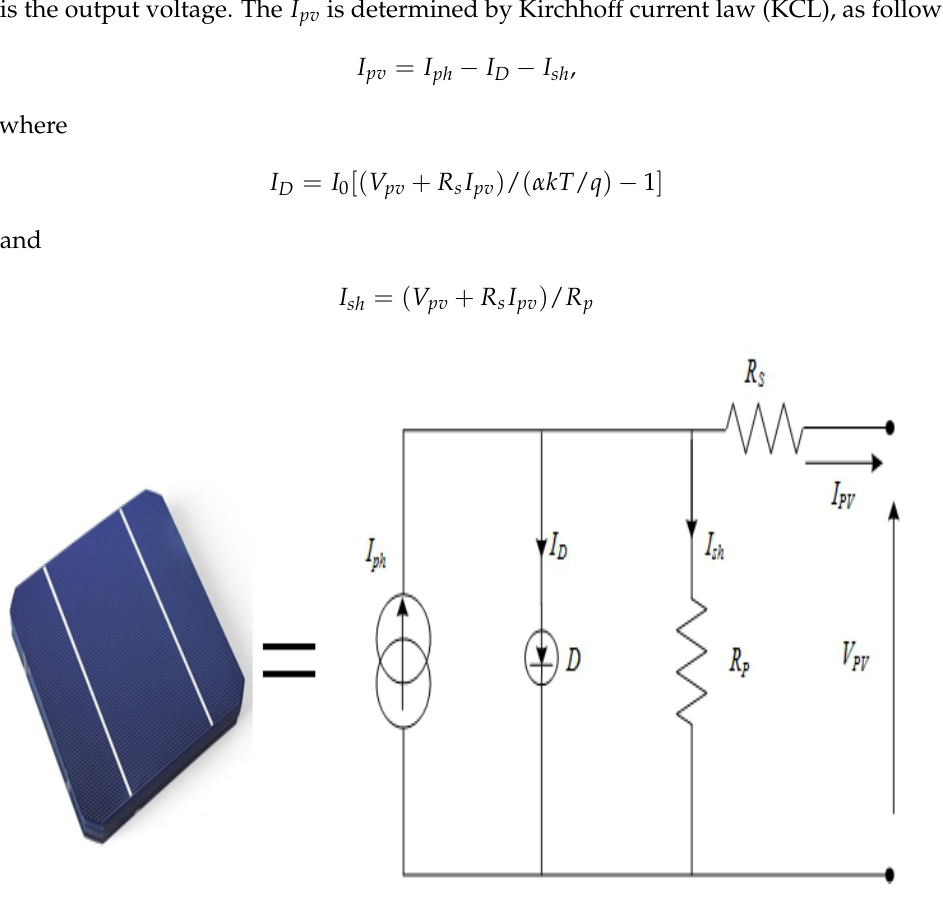
Figure 1. Single-diode model of PV